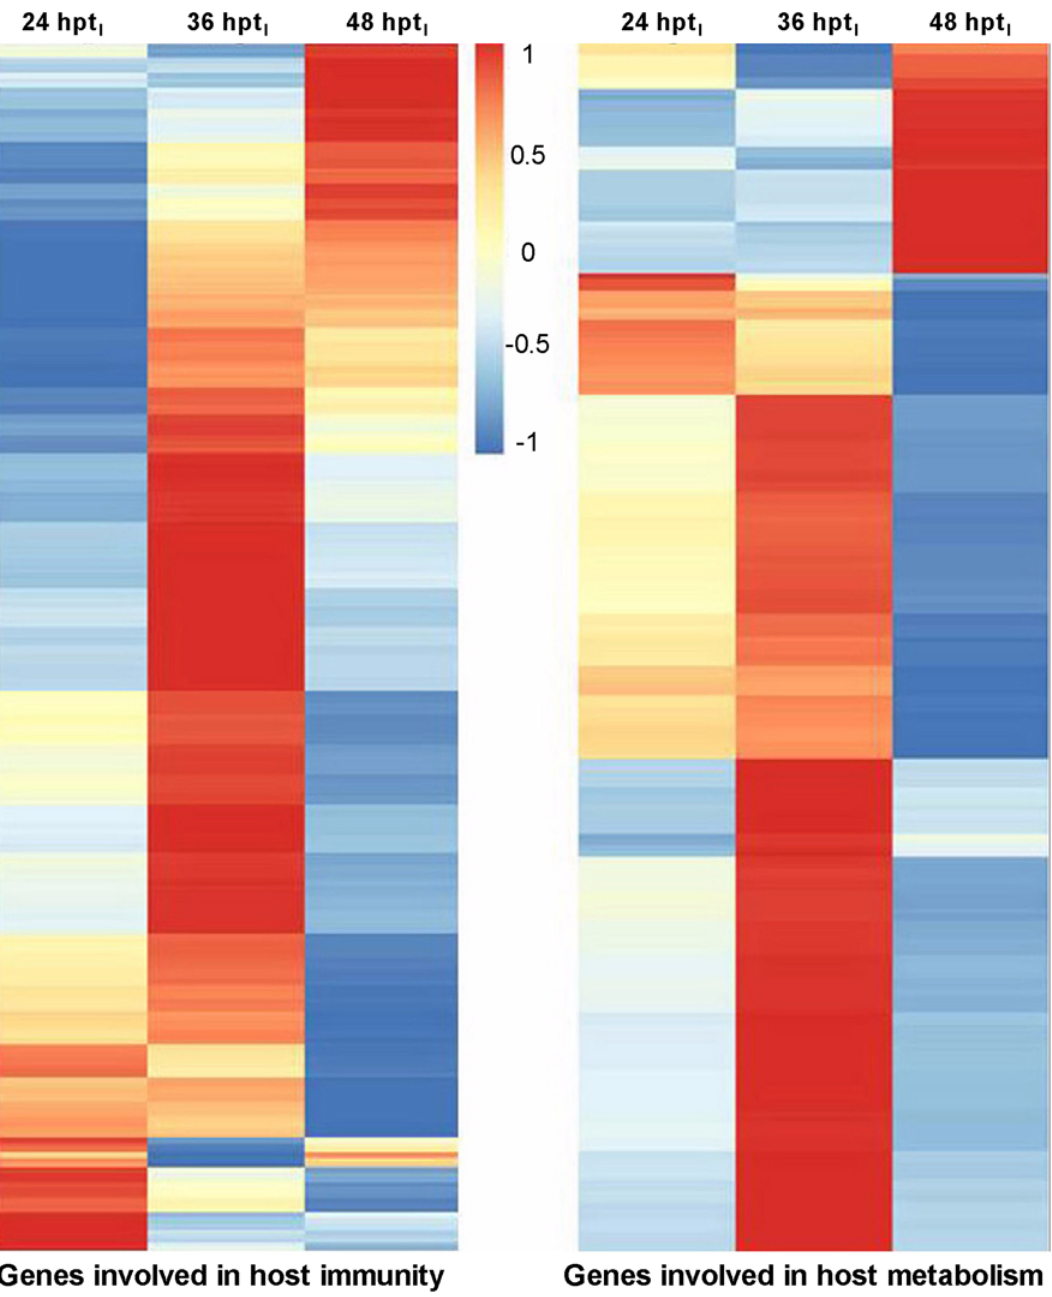
Fig 5. Heatmap for the distribution of P . xylostella immunity- and metabolism-related genes expressed at 24, 36 and 48 h after the B . bassiana infection. Scale bar: Gene expression level in the fungal treatment versus control.